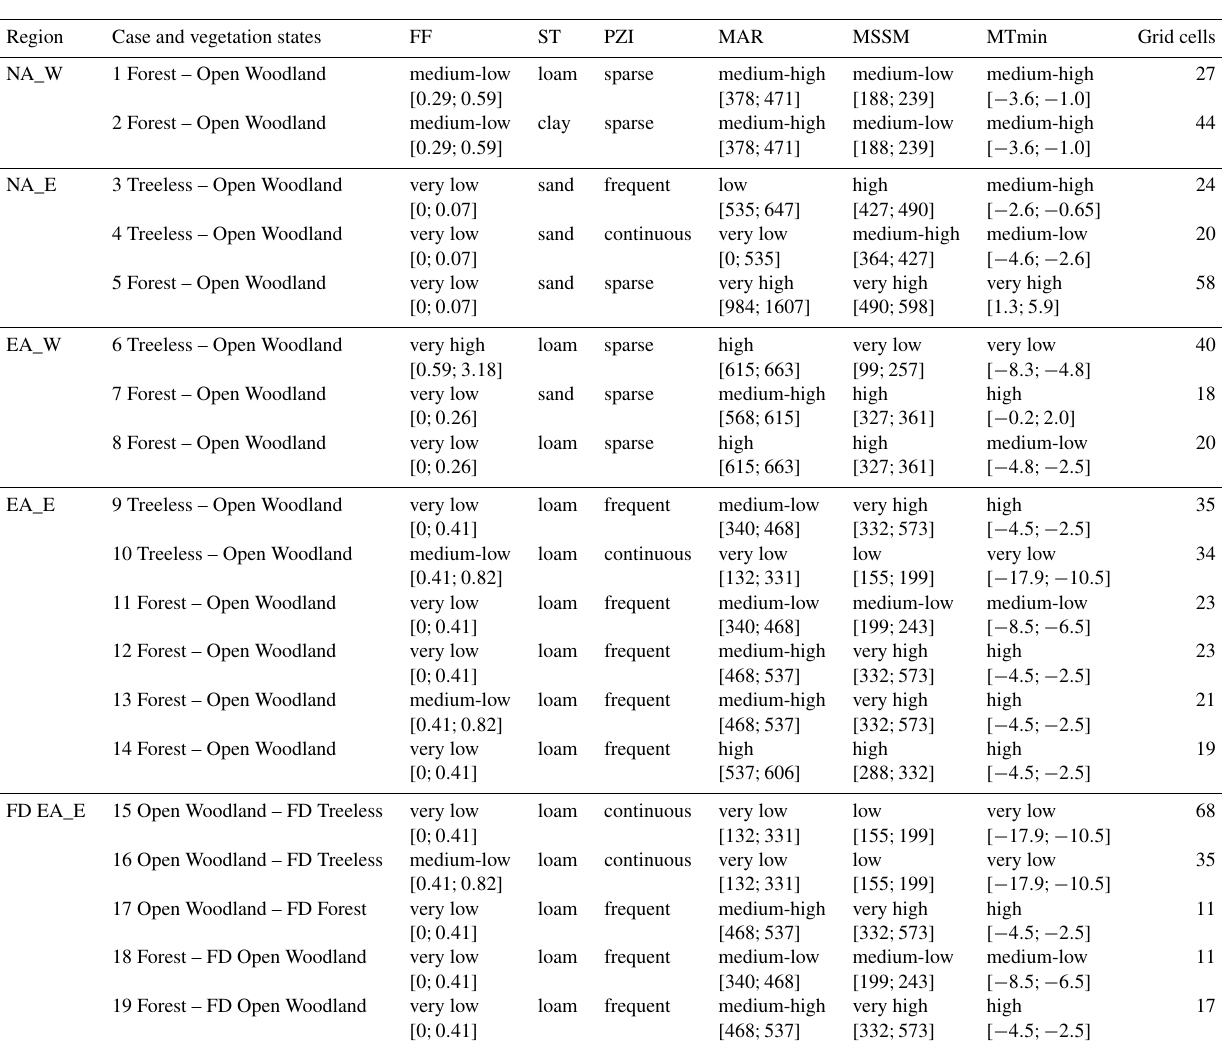
Table 4. Classes related to equivalent tree-cover states and fire-disturbed (FD) tree-cover states. The qualitative marks for fire frequency, mean annual rainfall, mean spring soil moisture, and mean minimum temperature are relative to the extremes of their distributions in the region of interest, and represent the bins into which the phase space is subdivided. Precise values for these bins are reported in brackets. Soil texture is described as belonging to the sand, loam, or clay group. Permafrost is described as sparse, discontinuous, frequent, or continuous. Each environmental variable class contains two possible vegetation states, e.g. forest and open woodland, that are consistently found under the same specified environmental